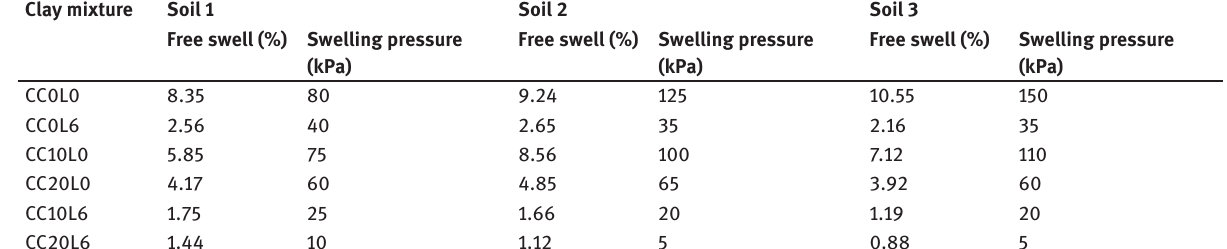
Table 7: Values of free swelling and swelling pressure versus the combinations of soil and stabilisers (calcined clay and lime). Clay mixture